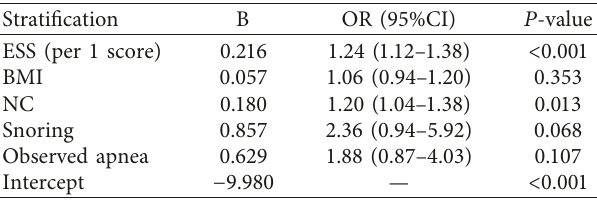
Table 3: Prediction factors for OSA from study population by multiple logistic regression